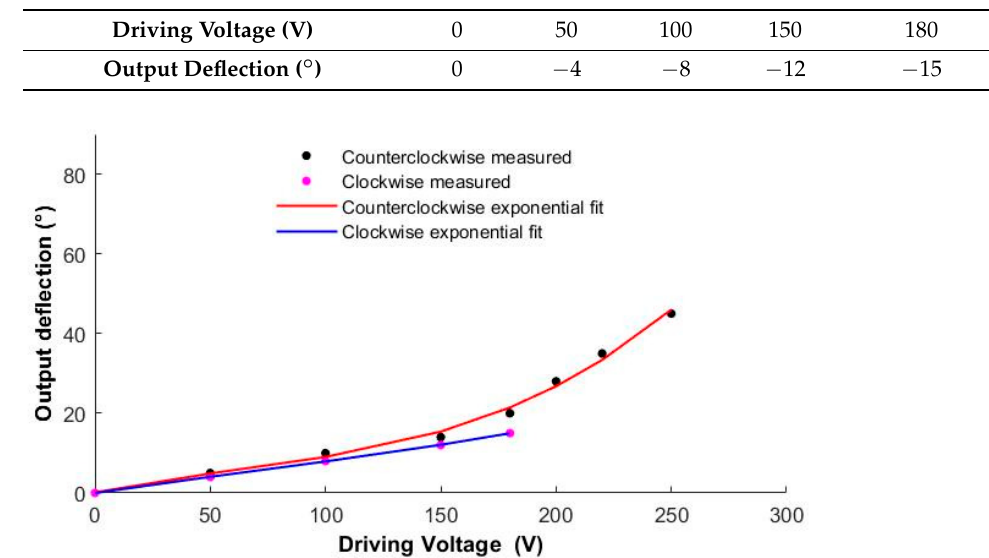
Table 3. The actual scale angle corresponding to the given reverse - biased driving voltage.